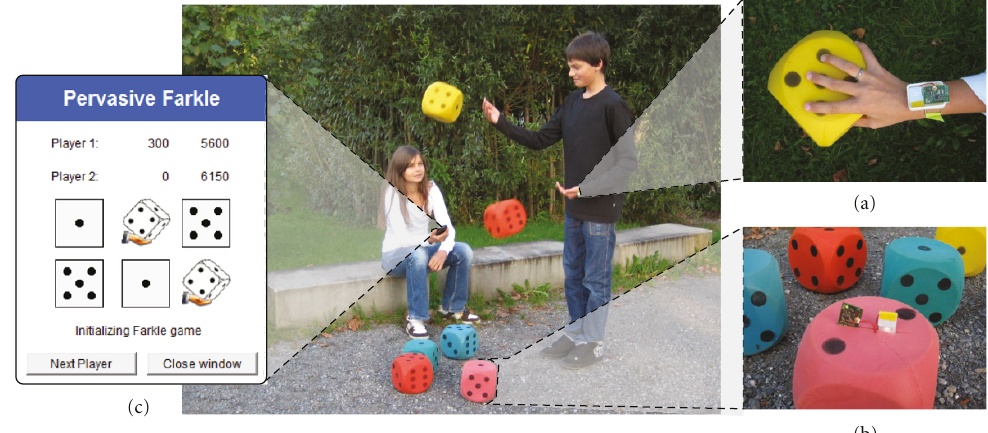
Figure 5: Two children wearing wristbands (a) playing the dice game with the smart dice (b). The game score is automatically updated on the mobile phone’s screen (c). Titan nodes with accelerometers are worn on the wrist (a) and integrated in the dice (b).